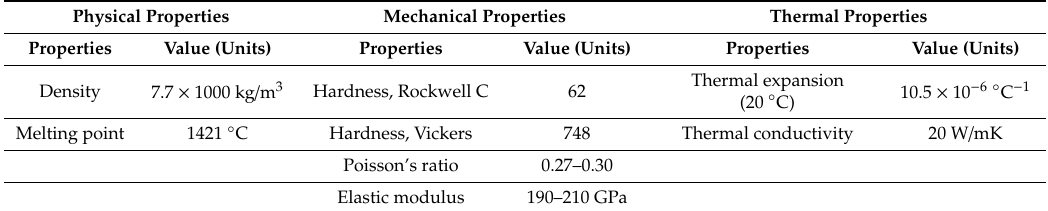
Table 2. Physical, mechanical, and thermal properties of tool steel D2-grade